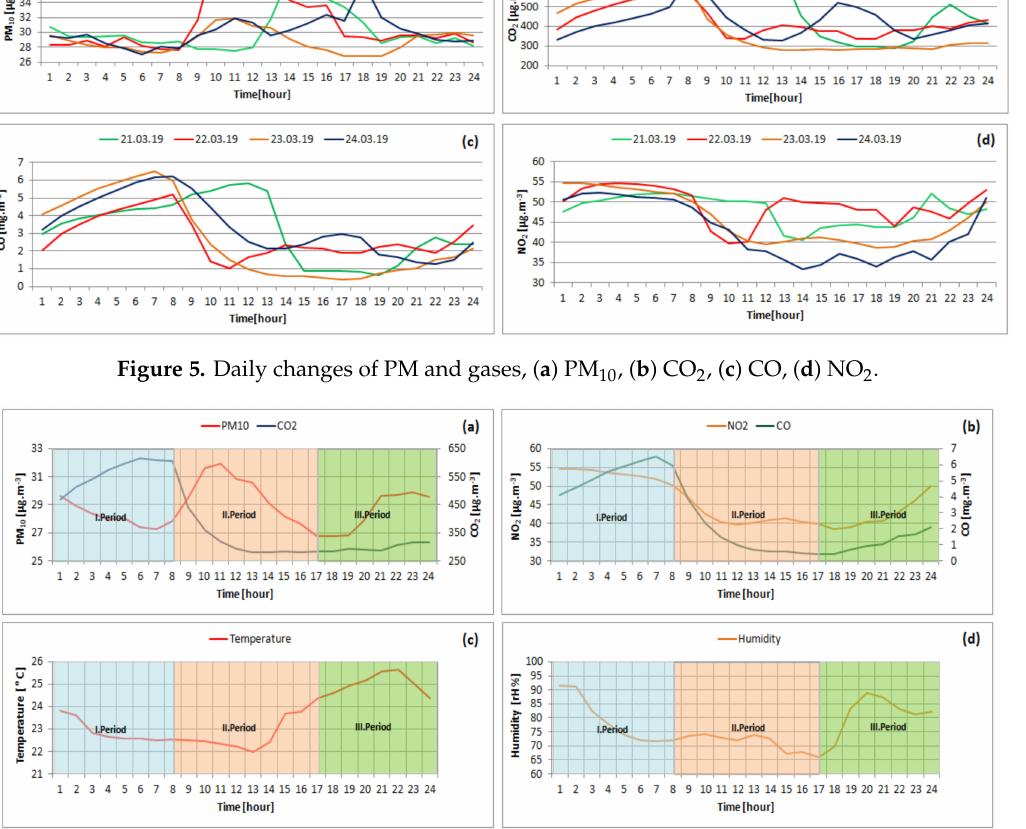
Figure 6. Hourly changes of climate parameters and gases values of day 3, ( a ) PM 10 - CO 2 , ( b ) NO 2 -CO, ( c ) temperature, ( d )